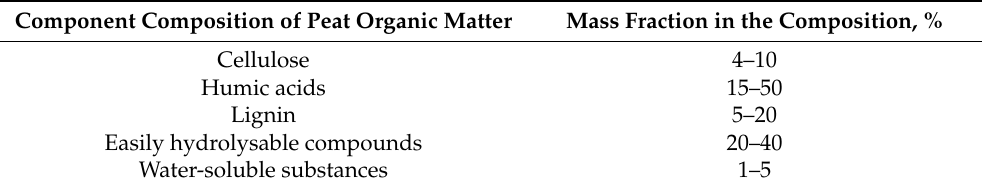
Easily hydrolysable